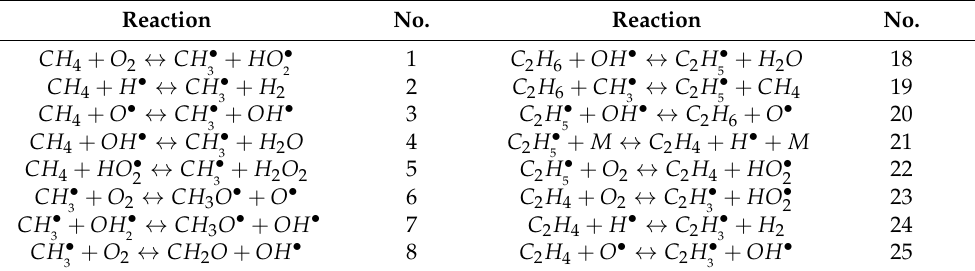
Table 2. Gas-phase reaction mechanism, as proposed by Chen et al. [96] for describing OCM reactions in the absence of catalysts and at atmospheric